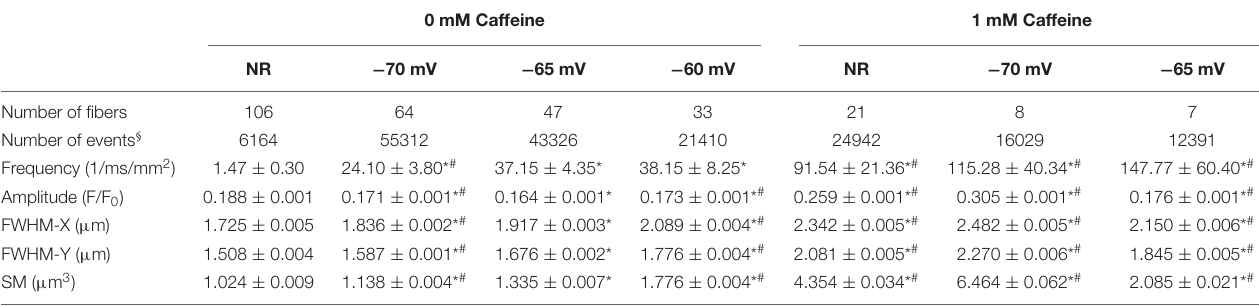
TABLE 2 | Parameters of sparks in different conditions.